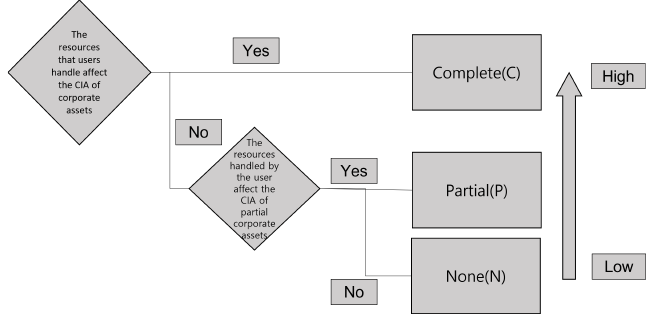
Figure 7. Resource importance diagram.